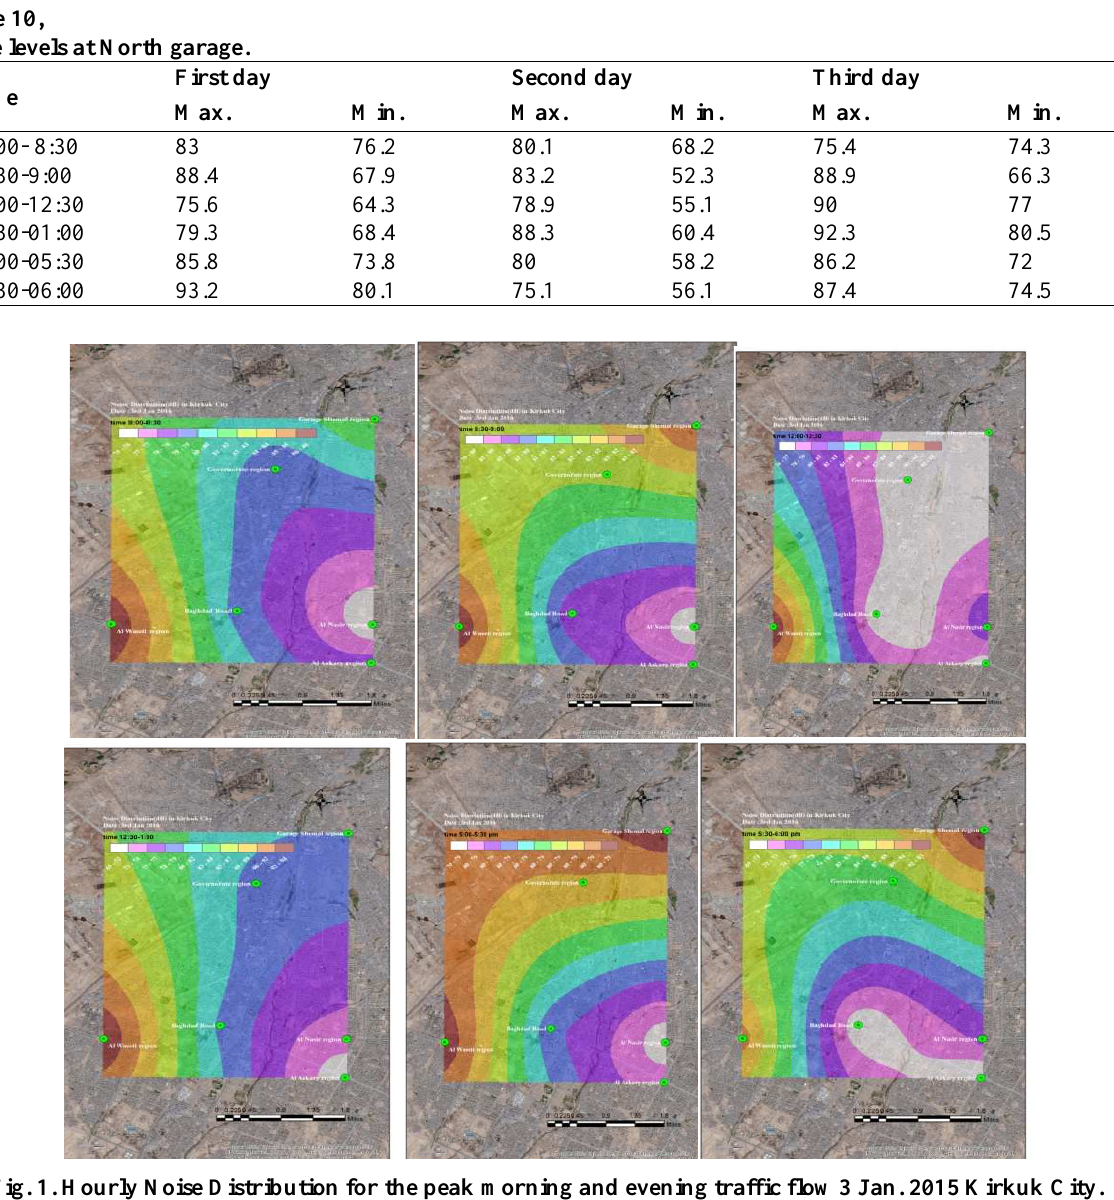
Fig. 1. Hourly Noise Distribution for the peak morning and evening traffic flow 3 Jan. 2015 Kirkuk 142